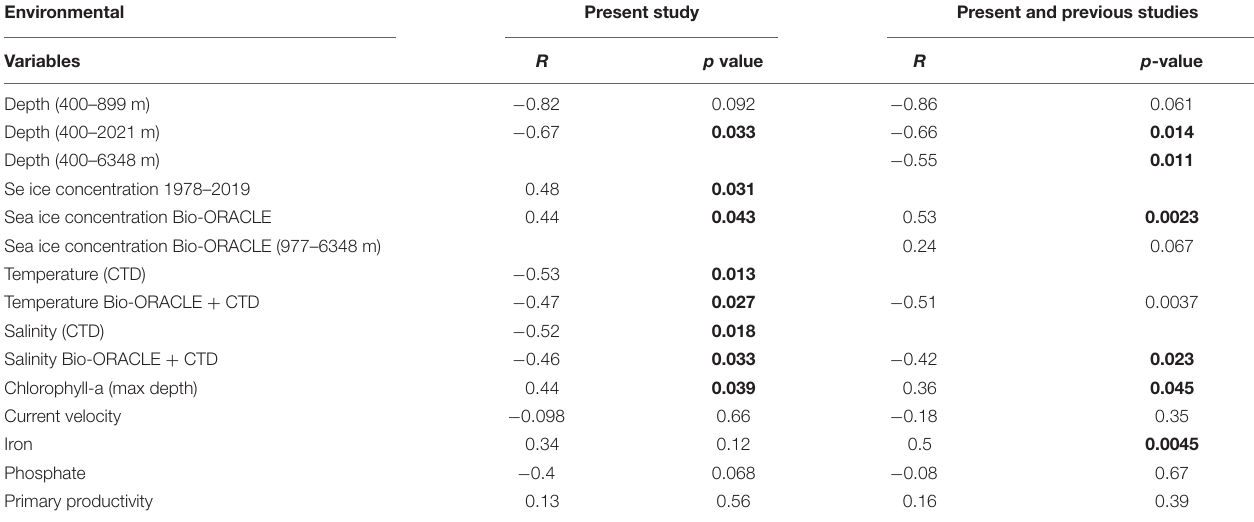
TABLE 4 | Pearson’s correlation analyses of environmental variables and peracarid abundances. Environmental Present